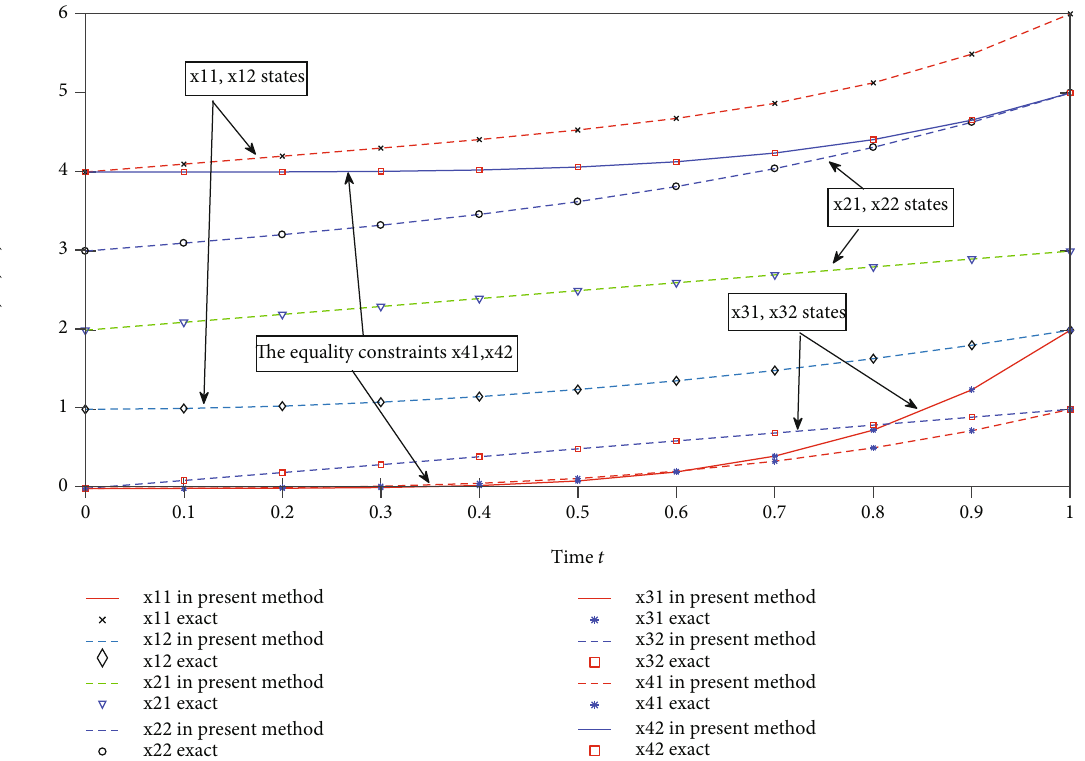
Figure 2: Comparison between the proposed approach and the exact